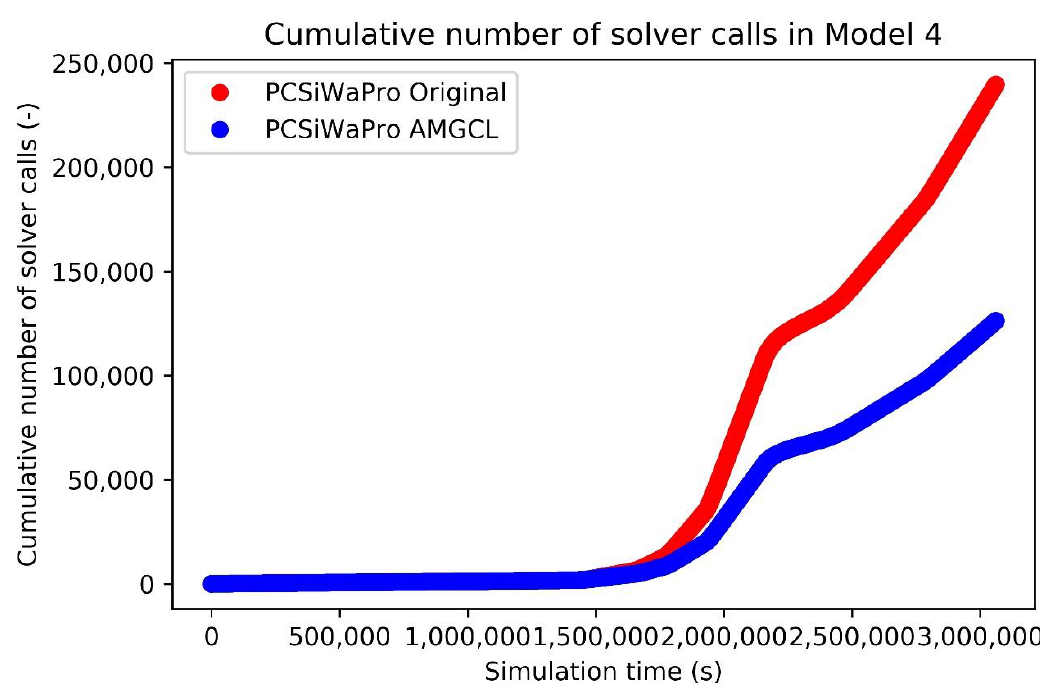
Figure 4. Comparison of the cumulative number of solver calls in Model 4. In the second half of the simulation period, PCSiWaPro AMGCL (blue) calls the solver less frequent than PCSiWaPro Original (red). This tells, that PCSiWaPro Original has greater problems with convergence than PCSiWaPro AMGCL.